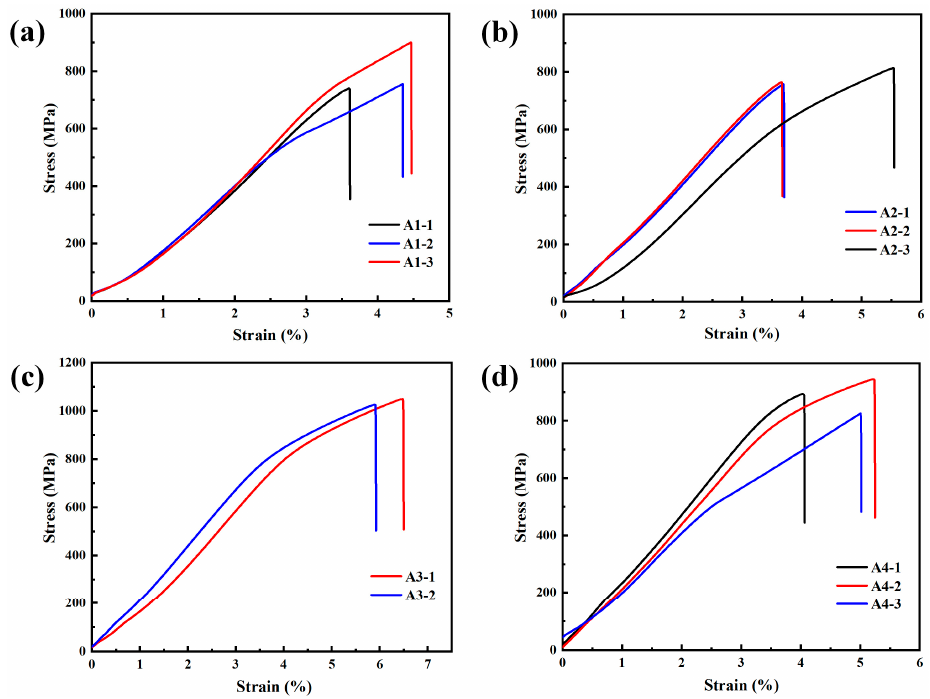
Figure 18. Stress–strain curves of the specimens: ( a ) A1, ( b ) A2, ( c ) A3, and ( d ) A4.